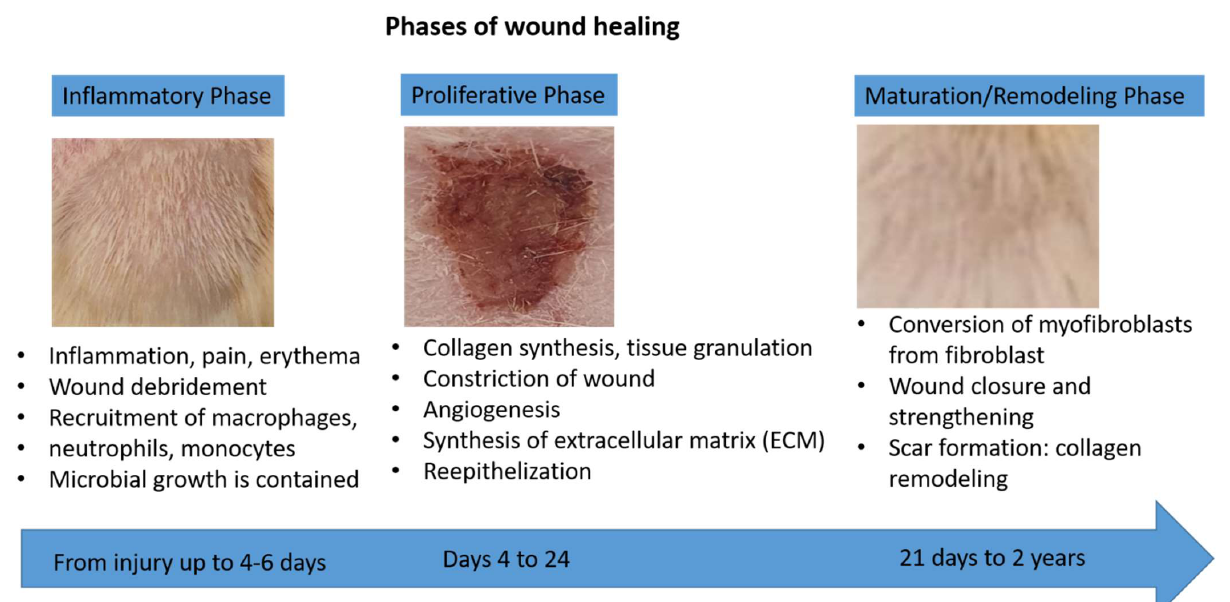
Figure 9. Phases of wound healing.